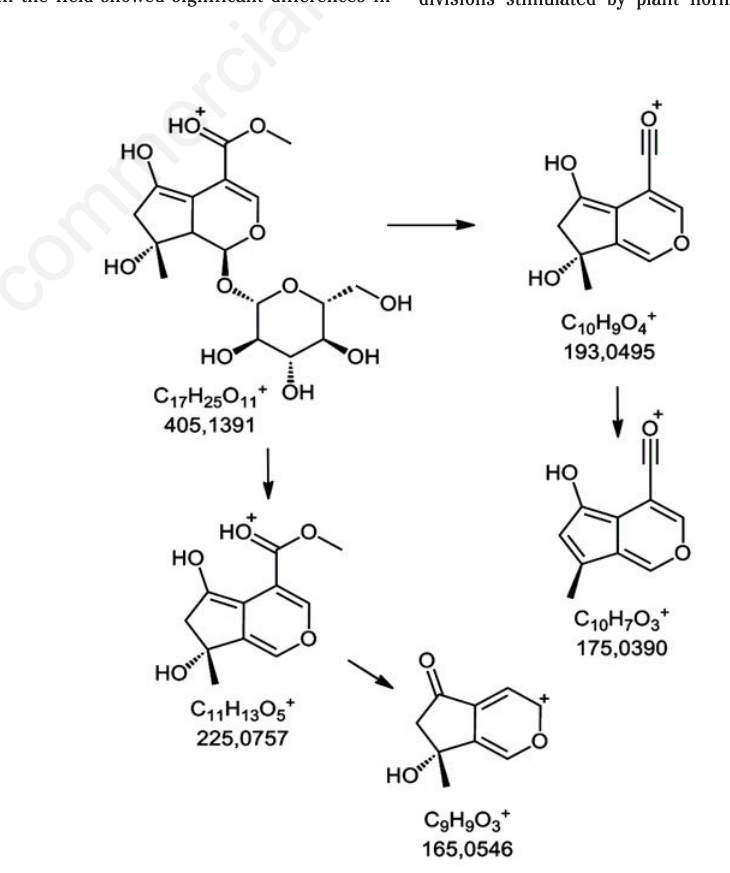
Figure 1. Proposed fragmentation of 6 β